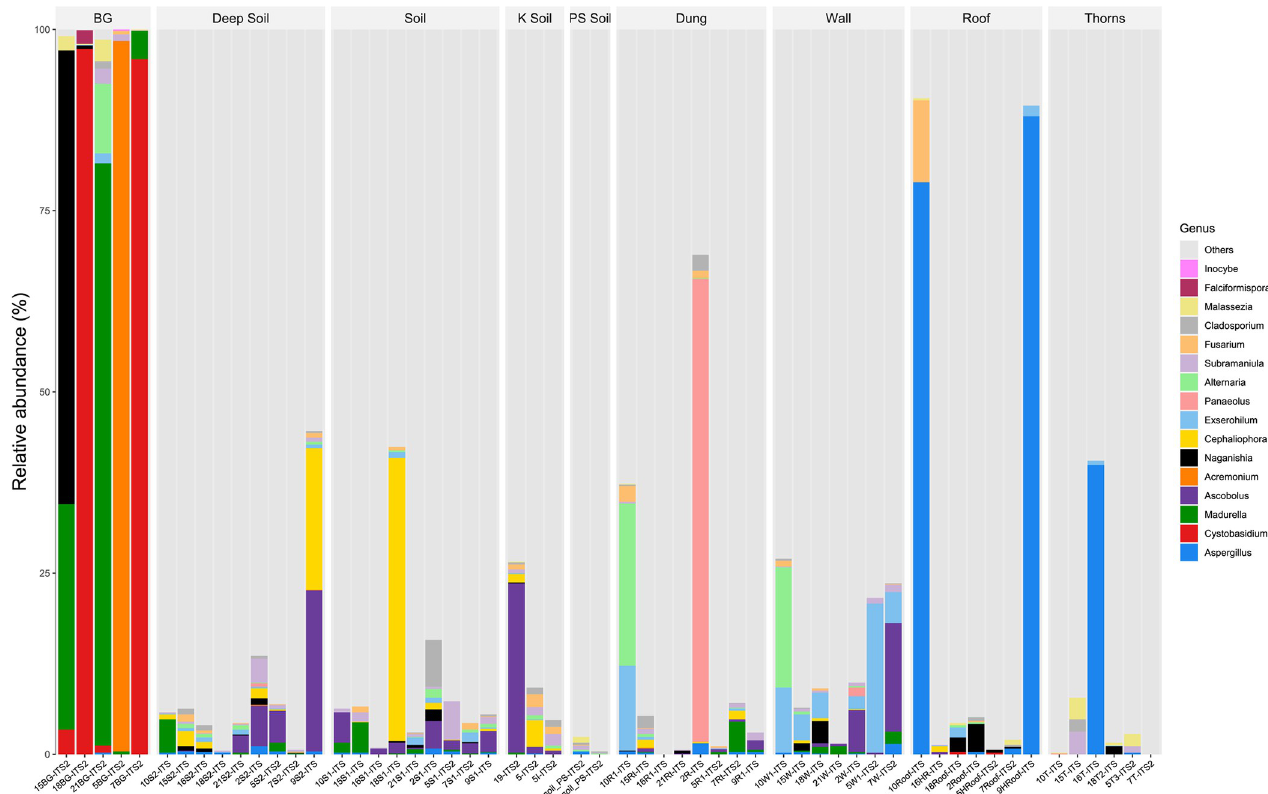
Fig 4. Taxa abundance in the samples grouped for type, all fungal genera detected in patients black grains samples are shown.